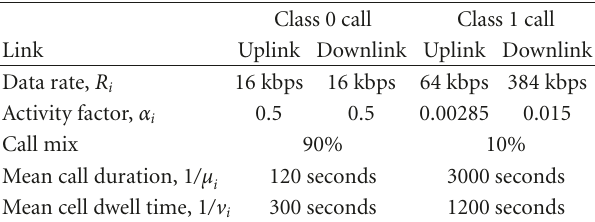
Table 1: Tra ffi c model parameter values [10].